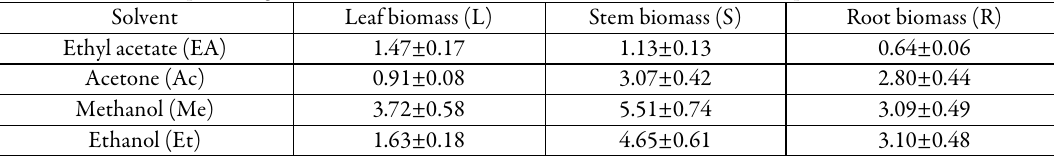
Table 1. The percentage yield of extractable constituents from the biomass of A.